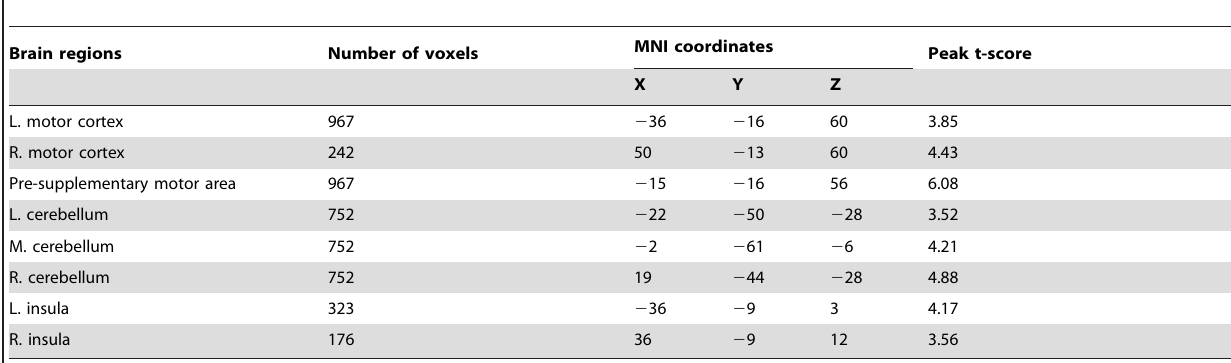
Table 2. Whole-brain searchlight analysis of age differences in motor distinctiveness.